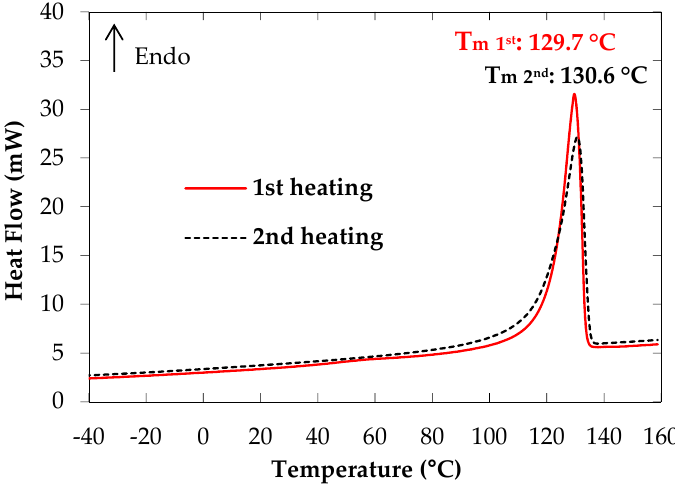
Figure 5. Differential scanning calorimetry (DSC) results of PEX waste.